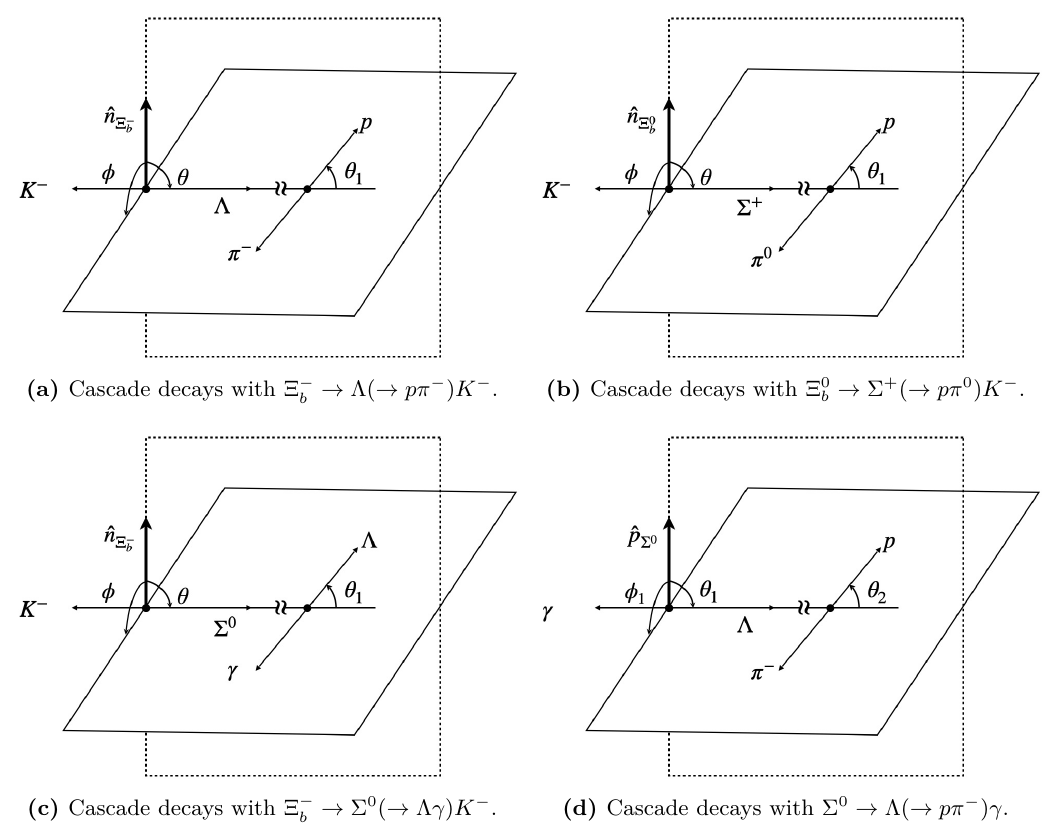
Figure 2. Angles in D ( ~ Ω) for cascade